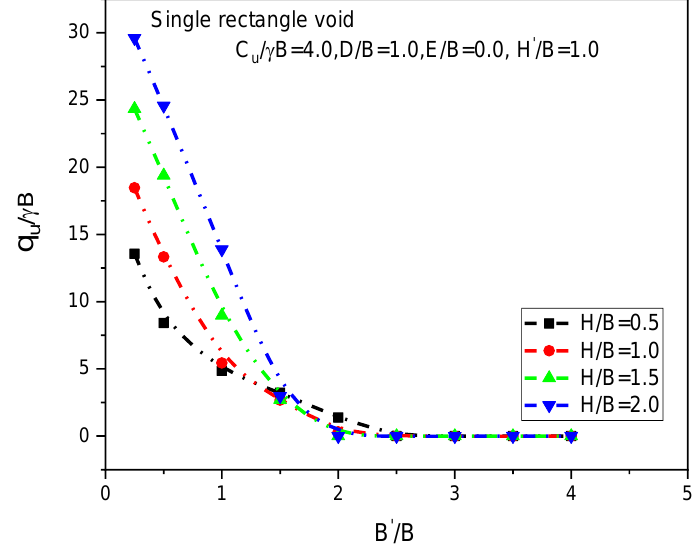
Figure 9. Effect of the void width on the ultimate bearing capacity ratio qu/γB.